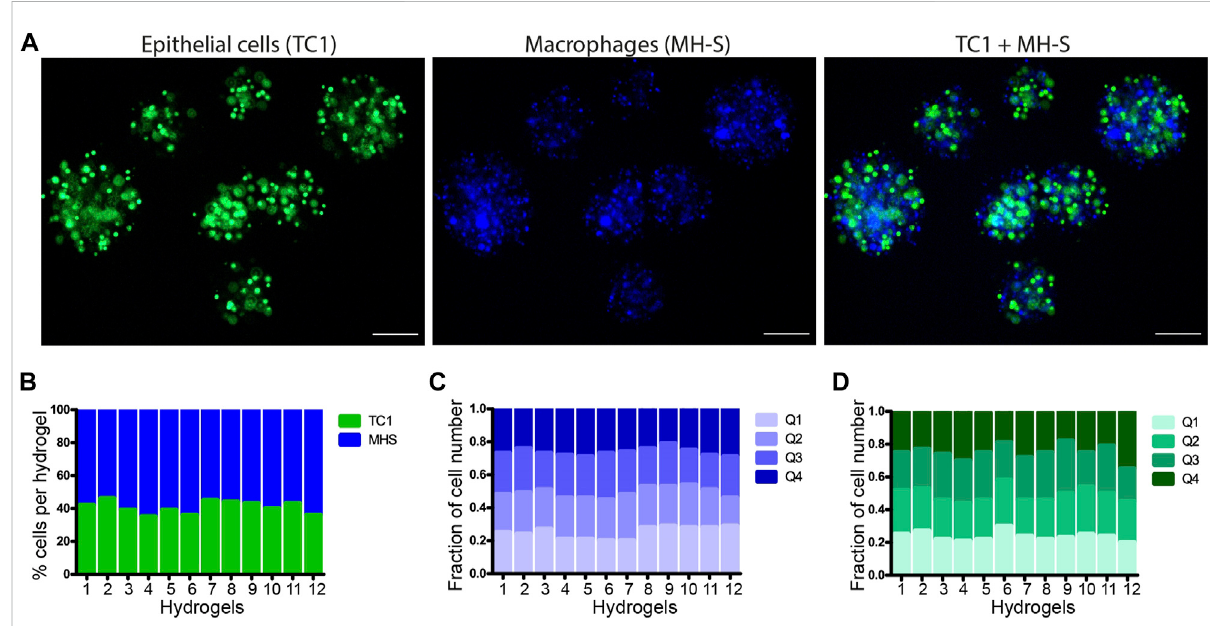
FIGURE 2 Equal distribution of two co-encapsulated cells inside the microspheres. (A) Representative fl uorescent images of alveolar epithelial TC1 cells andmacrophageMH-Scellsencapsulatedaloneortogetherin1:1proportion(TC1+MH-S). (B) BarplotshowingpercentilesofTC1(green)andMH- S (blue) cells inside twelve different microspheres. (C,D) Bar plot showing the fraction of MH-S cells (C) and TC1 cells (D) per quarter (Q1-Q4) inside twelve different